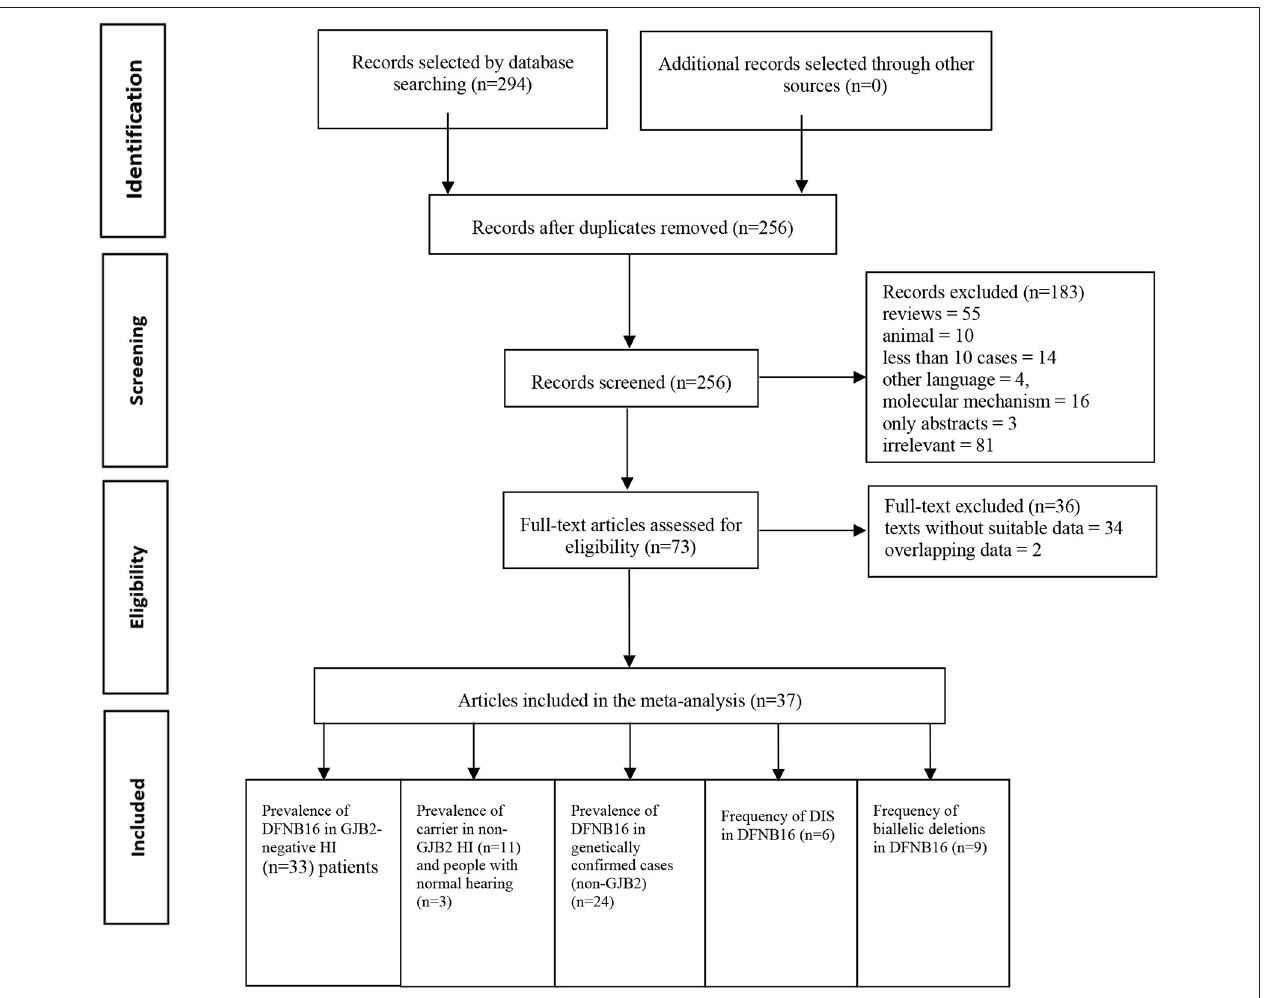
FIGURE 1 | Standard data extraction